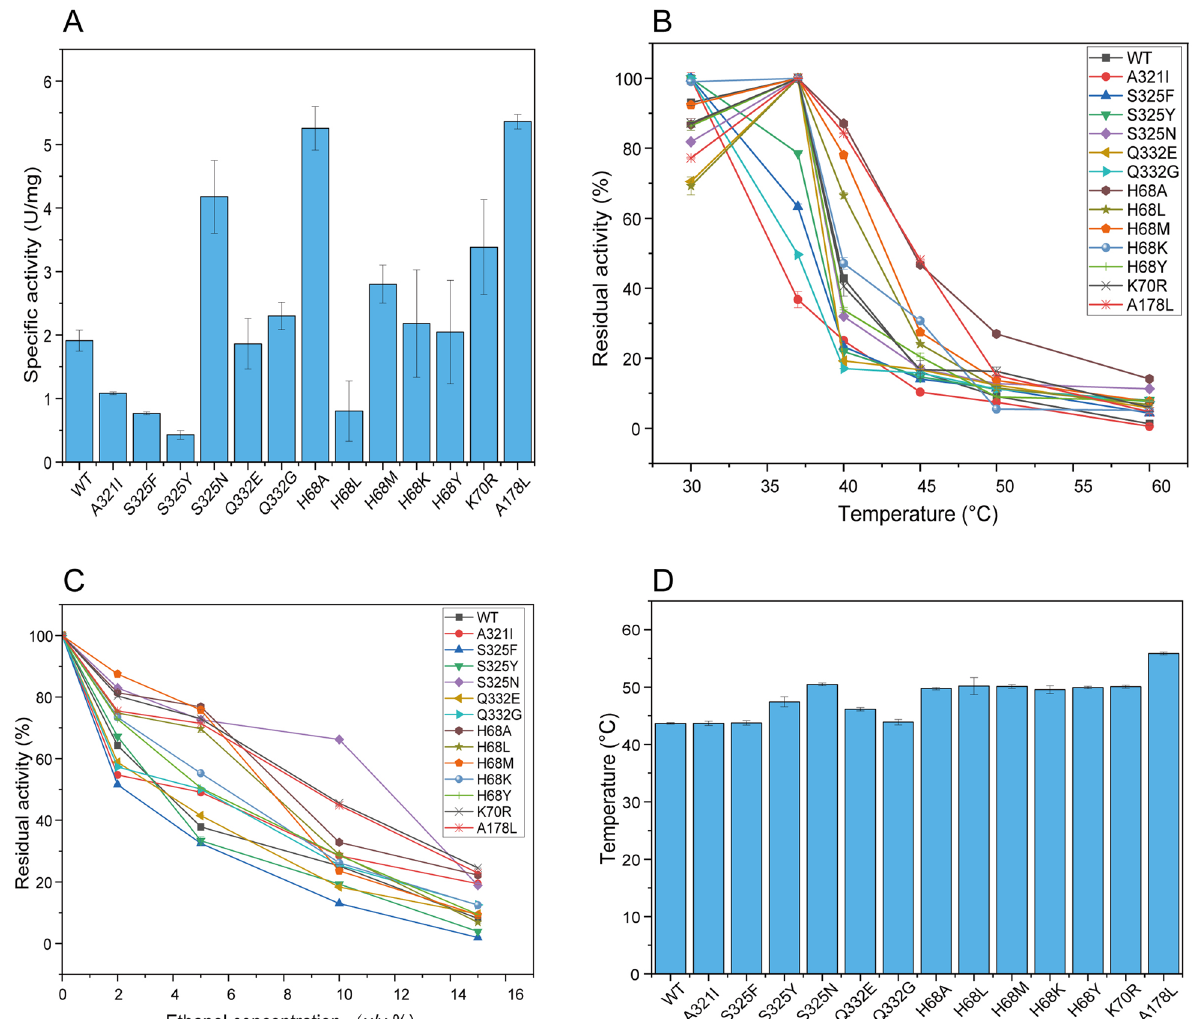
Fig. 2 Enzymatic properties of single mutant proteins. A Specific enzymatic activity of single mutant proteins. B Optimal temperature of single mutant proteins. C Ethanol tolerance of single mutant proteins. D Variation in T m values of single mutant